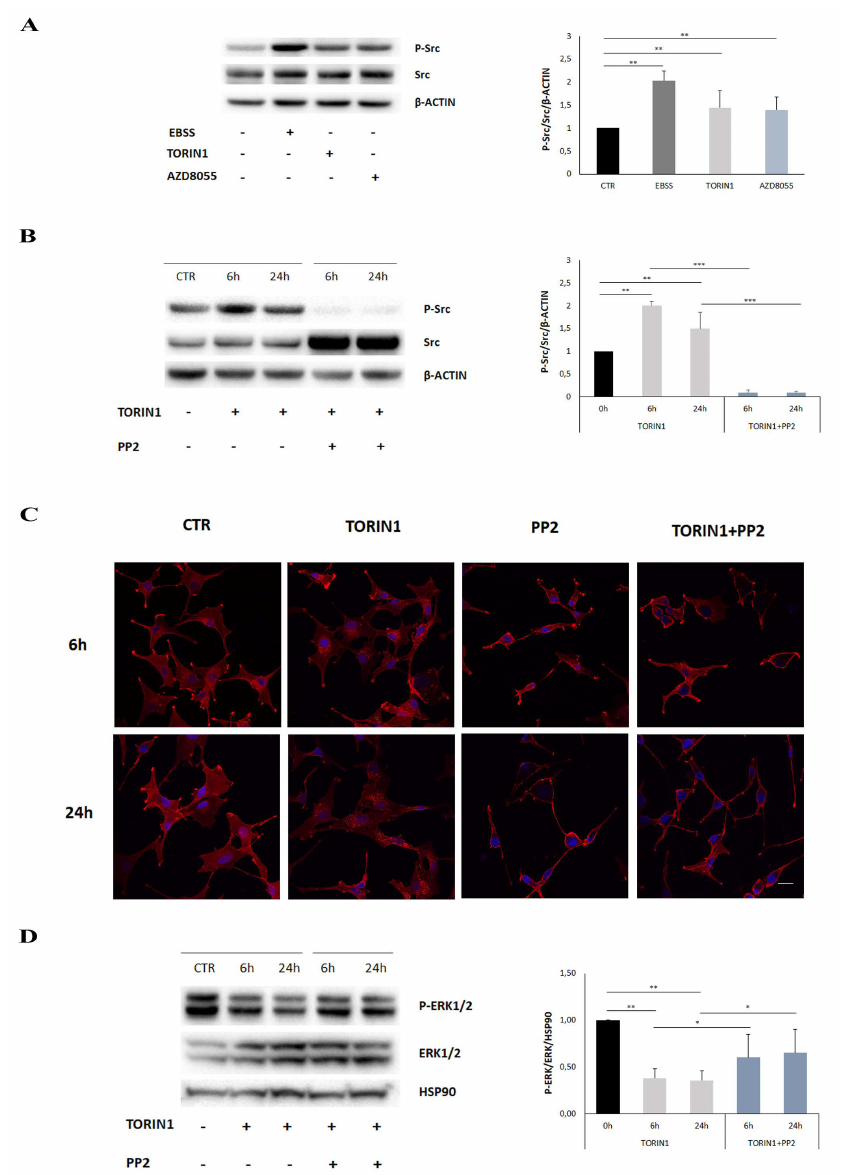
Figure 6. mTOR inhibition leads to SRC activation. ( A ) U87MG cells were cultured in complete DMEM (CTR) or aminoacid- and serum- free medium (EBSS) or in DMEM in the presence of 250 nM Torin1 or 100 nM AZD8055 for 18 h. Western blot analysis was performed by using specific antibodies for the total (SRC) and the phosphorylated (Y416) form of SRC (P-Src). β -ACTIN was used as loading control. ( B ) U87MG cells were cultured in DMEM in the presence of Torin1 pre-incubating or not with 20 µ M PP2 inhibitor for the indicated time points. Western blot analysis was performed by using specific antibodies for the total (SRC) and the phosphorylated (Y416) form of SRC (P-Src). β -ACTIN was used as loading control. The graphs represent the mean ± SD of three di ff erent experiments. Statistical significance: ** p < 0.01 Student t -test, *** p ≤ 0.001 Student t -test ( C ) Immunocytochemistry and confocal analysis for EGFR localisation (red) were performed in U87MG, upon 6 h and 24 h of Torin1 and PP2 treatments, as indicated. Hoechst 33342 was used to stain nuclei (blue). Scale bar, 30 µ M. ( D ) U87MG cells were cultured in DMEM in the presence of Torin1 pre-incubating or not with 20 µ M PP2 inhibitor for the indicated time points. Western blot analysis was performed by using specific antibodies for the total (ERK1 / 2) and the phosphorylated form of ERK1 / 2 (P-ERK1 / 2). HSP90 was used as loading control. The graph represents the mean ± SD of three di ff erent experiments. Statistical significance: * p < 0.05 Student t -test, ** p < 0.01 Student t